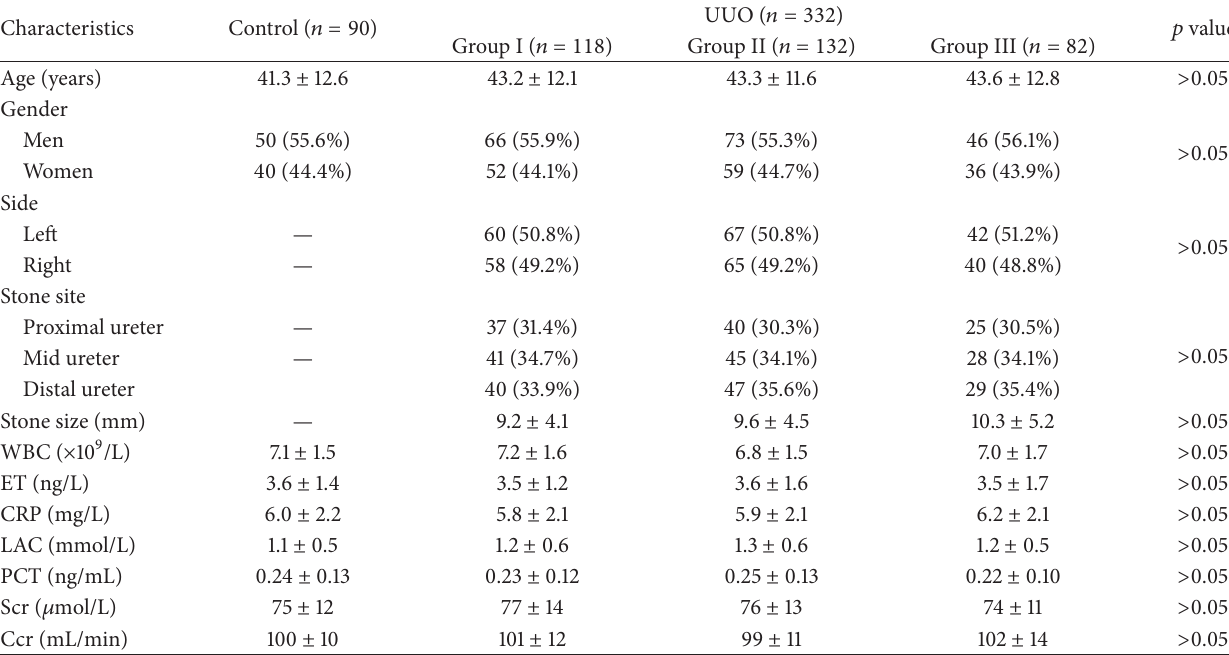
Table 1: Baseline characteristics of study